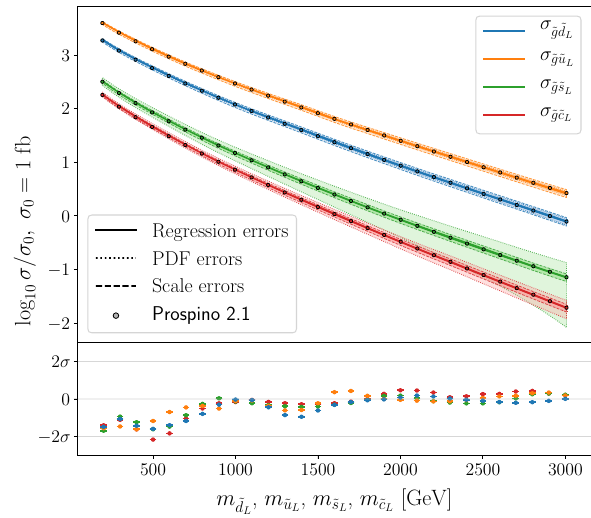
Fig. 10 Gluino–squark pair-production cross-section as a function of gluino mass (left) and squark masses (right), for production of first and second-generation squarks. Shown are individual (left-handed) squark final states (colours) and the sum of all first and second-generation final states (black). In the left-hand plot all squark masses are fixed at 1TeV.